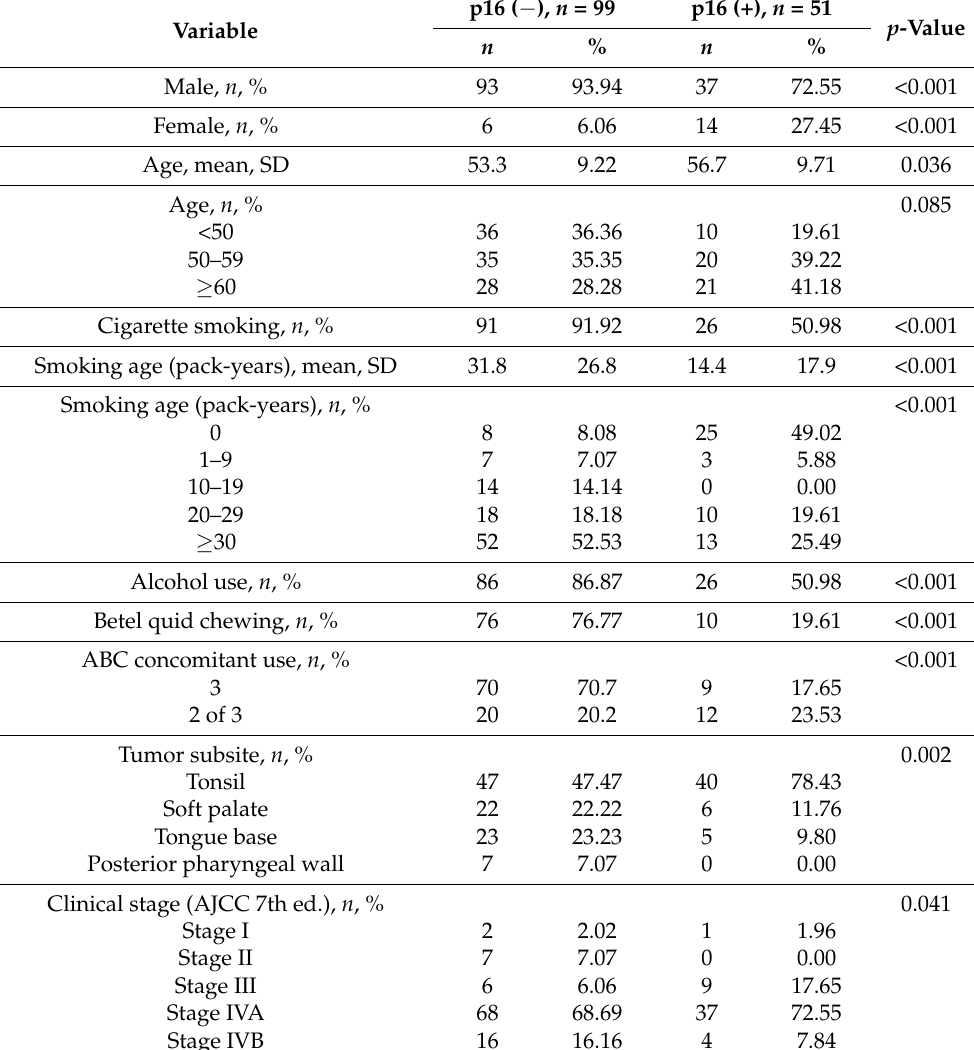
Table 1. Baseline characteristics of the study